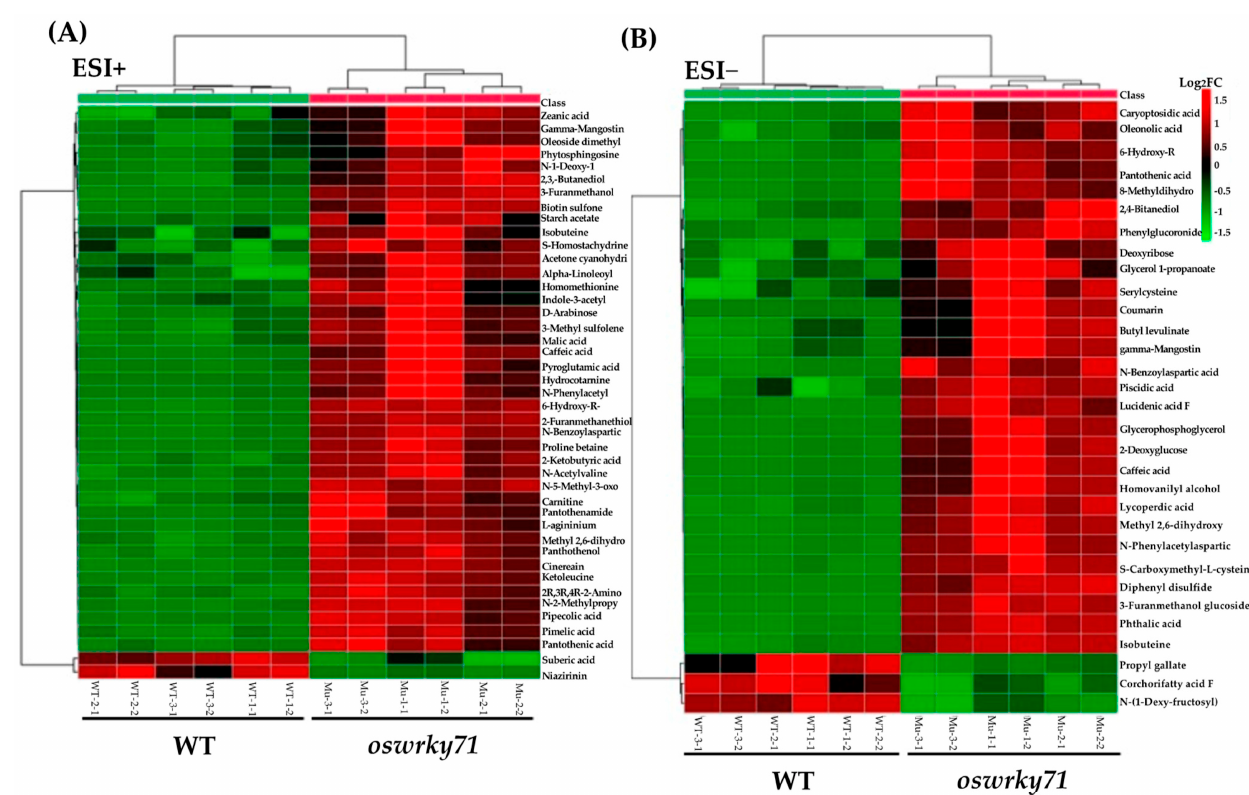
Figure 4. Heat map showed the differential metabolites between WT and oswrky71 threshed grain samples. ( A ) Hierarchical cluster analysis of differential metabolites from ESI+ mode. ( B ) Hierarchical cluster analysis of differential metabolites from ESI − mode. Red indicates upregulation of metabolite expression; green, downregulation.